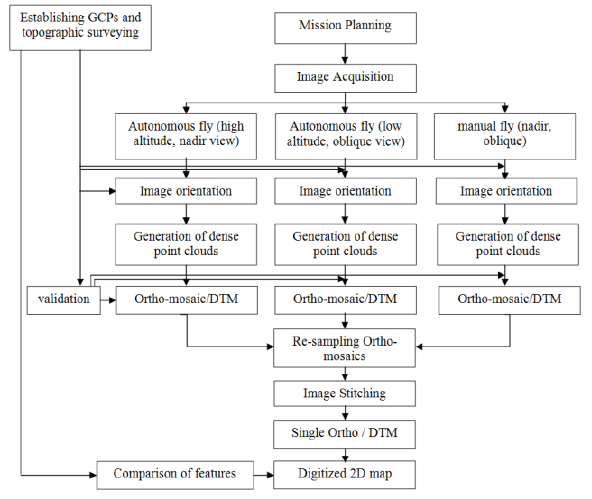
Figure 2: Schematic diagram of workflow